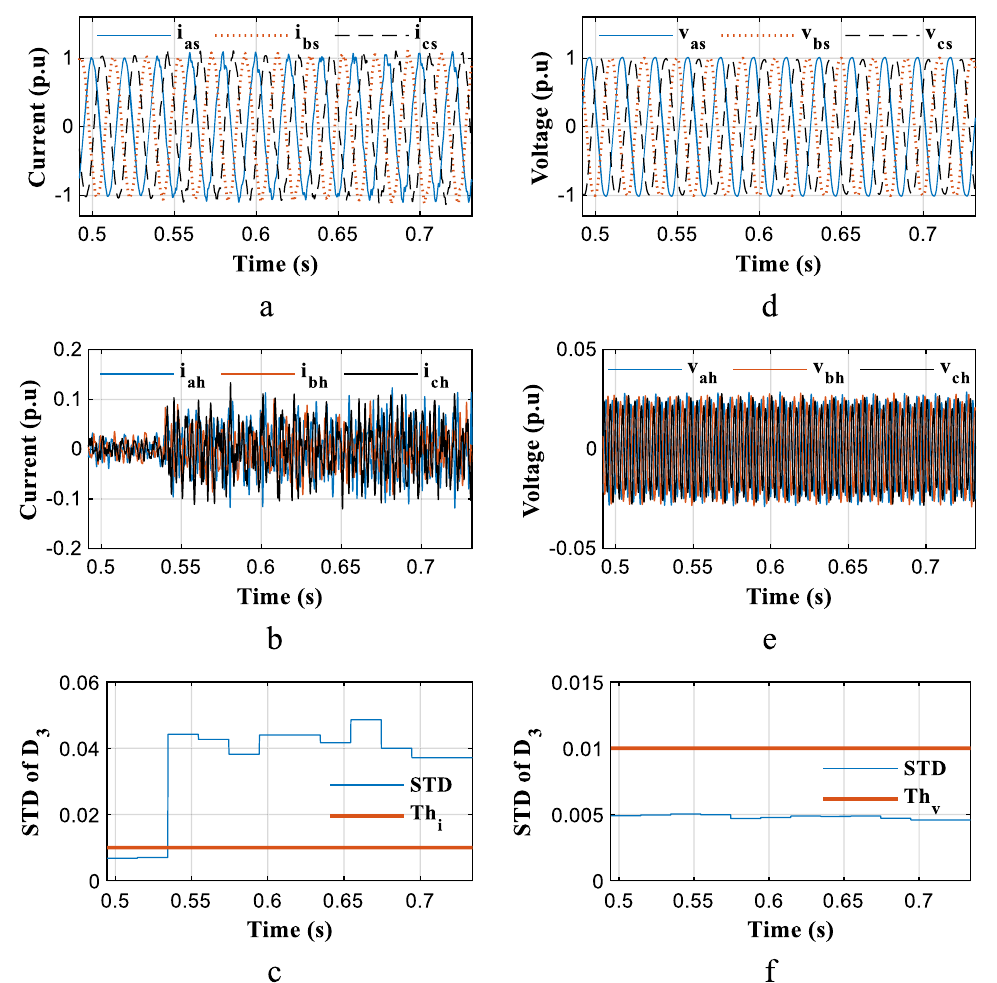
Fig. 16 Performance evaluation of proposed criteria using practical results for an inter-turn fault ( µ = 0.05 ), a Three-phase stator current signals, b High-frequency components of three-phase stator current signals, c The current criterion, d Three-phase stator voltage signals, e High-frequency components of three-phase stator voltage signals, f The voltage